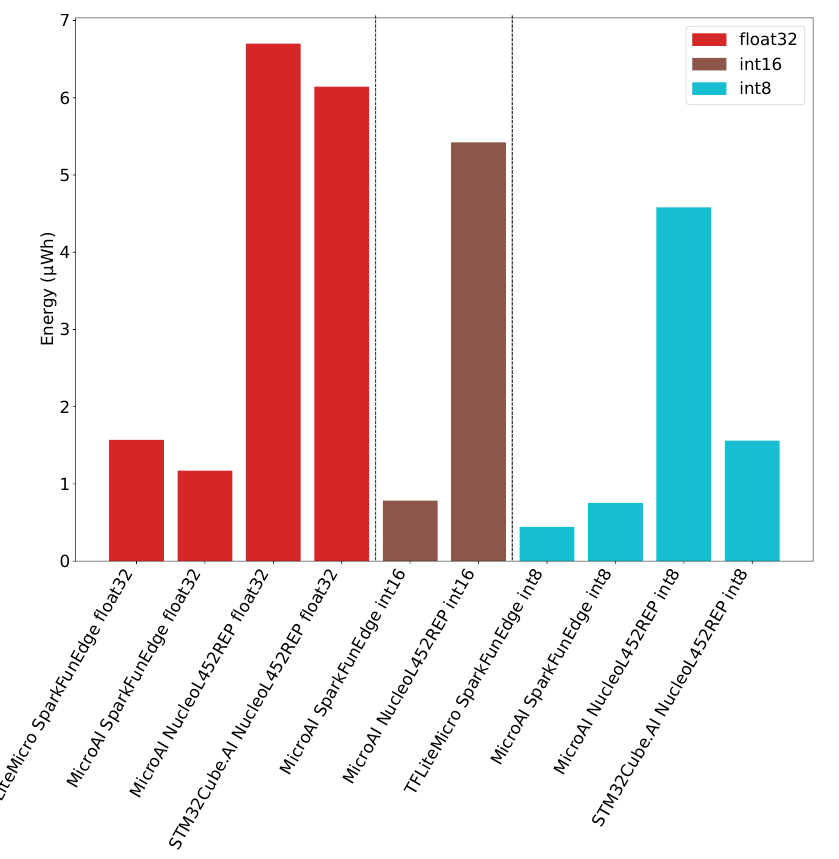
Figure 13. Energy consumption for 1 input for TFLite Micro, STM32Cube.AI and MicroAI with 80 filters per